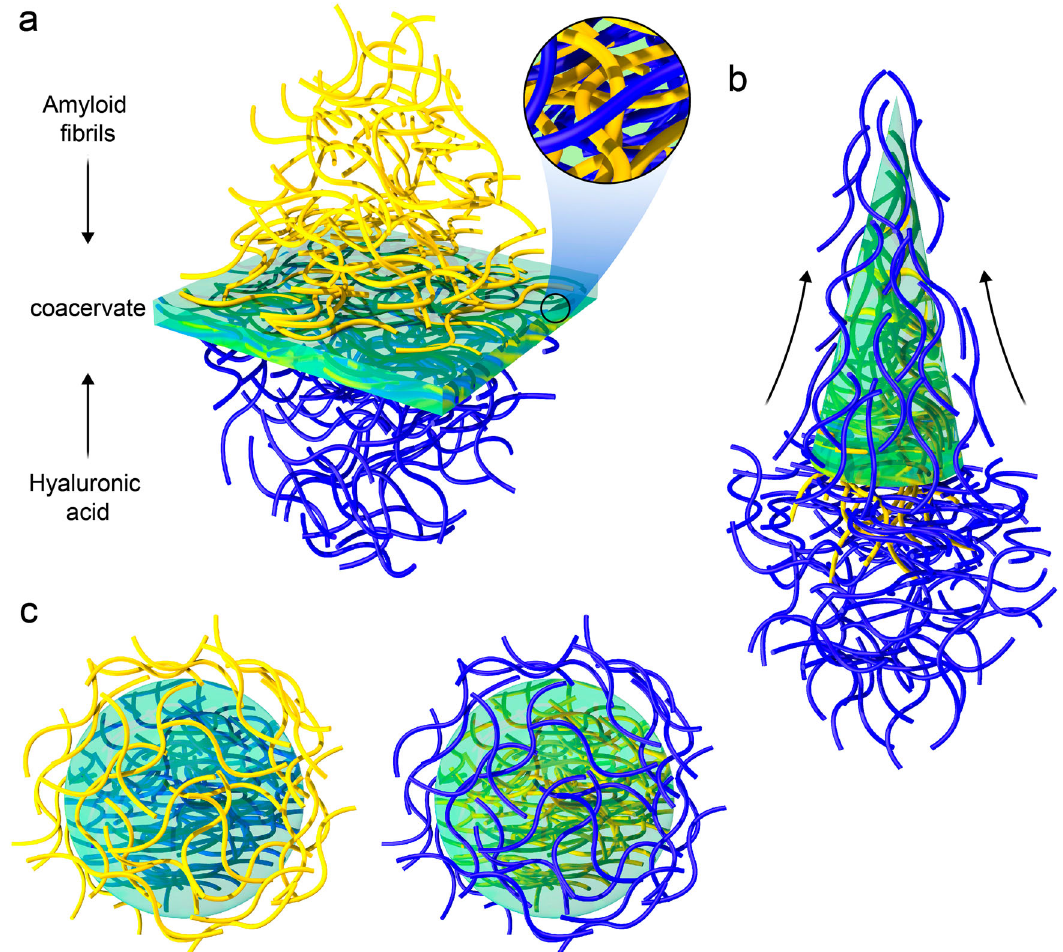
Fig. 1 | Schematic of AF and HA interfacial coacervation for developing advanced materials. a fi lms, b fi bers and c